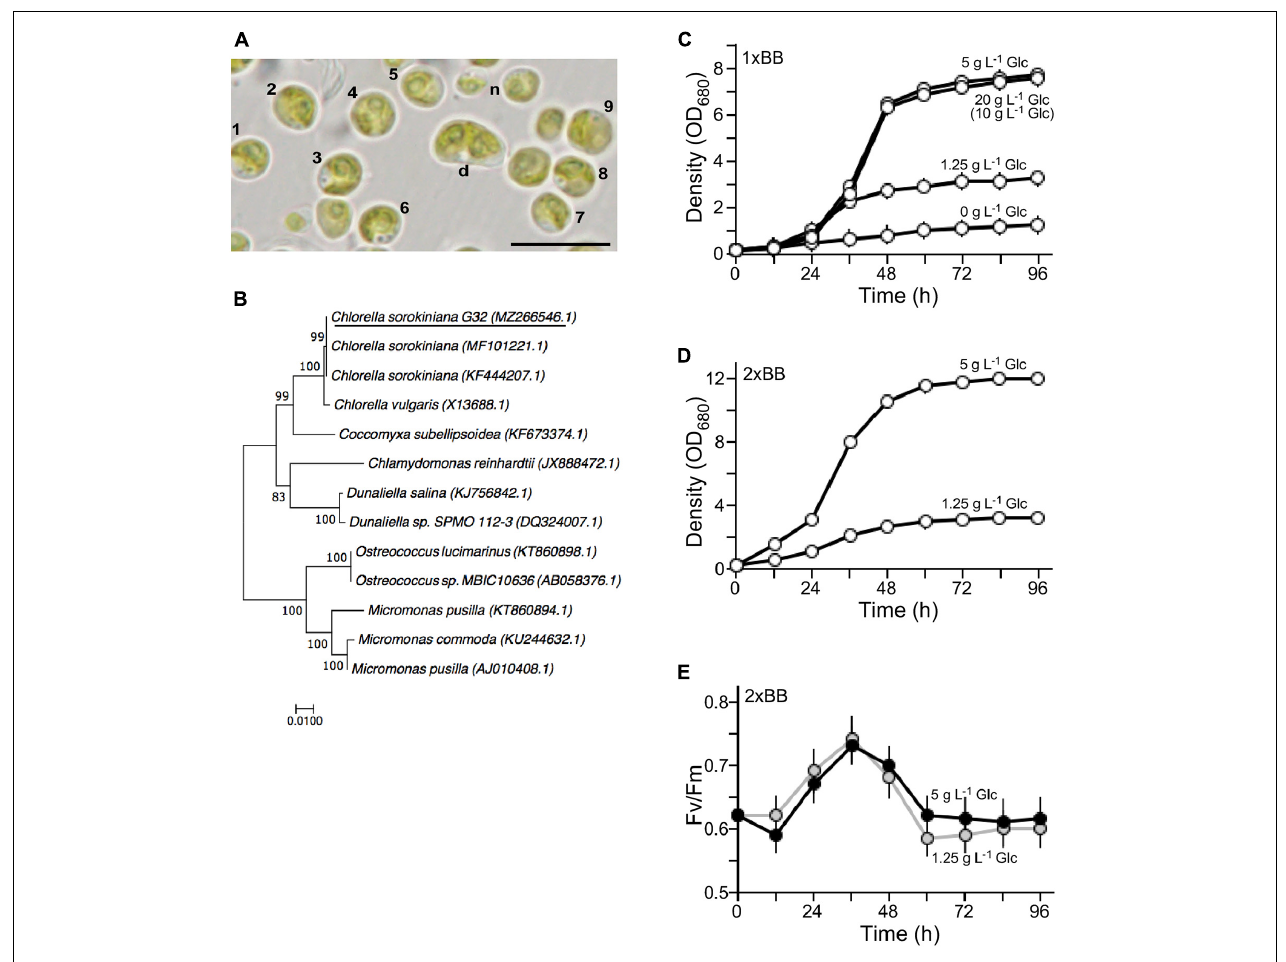
FIGURE 1 | Characterization of the novel isolate G32. (A) Morphology of the G32 cells in 1 × BB medium supplemented with 1.25 g L − 1 glucose. Cells with numbers are used in estimation of average cell size. n and d stand for newborn and dividing cells, respectively. A scale bar of 10 µ m is shown. (B) Phylogenetic tree based on 18S rDNA sequence. NCBI accession numbers of sequences are shown in brackets. G32 is underlined. (C) Growth curves of G32 cells cultivated in 1 × BB medium supplemented with various glucose concentrations are indicated. (D) Growth curves of G32 cells cultivated in 2 × BB medium supplemented with 5 and 1.25 g L − 1 glucose. (E) Photosynthesis efficiency of G32 cells during growth as shown in (D)